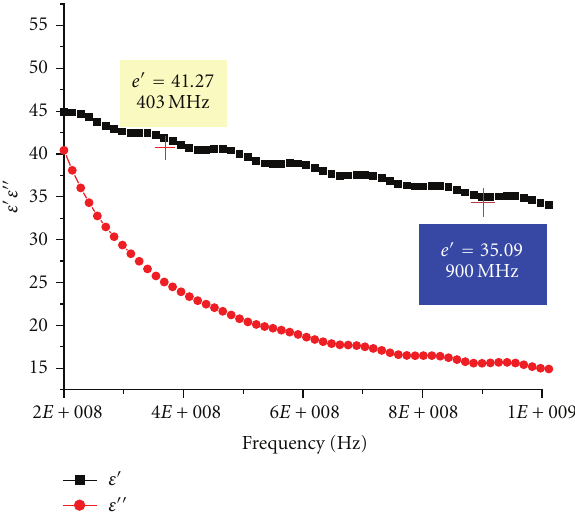
Figure 8: Measured permittivity of tissue-equivalent liquid. bottom ground plane, respectively. Figure 6(b) shows